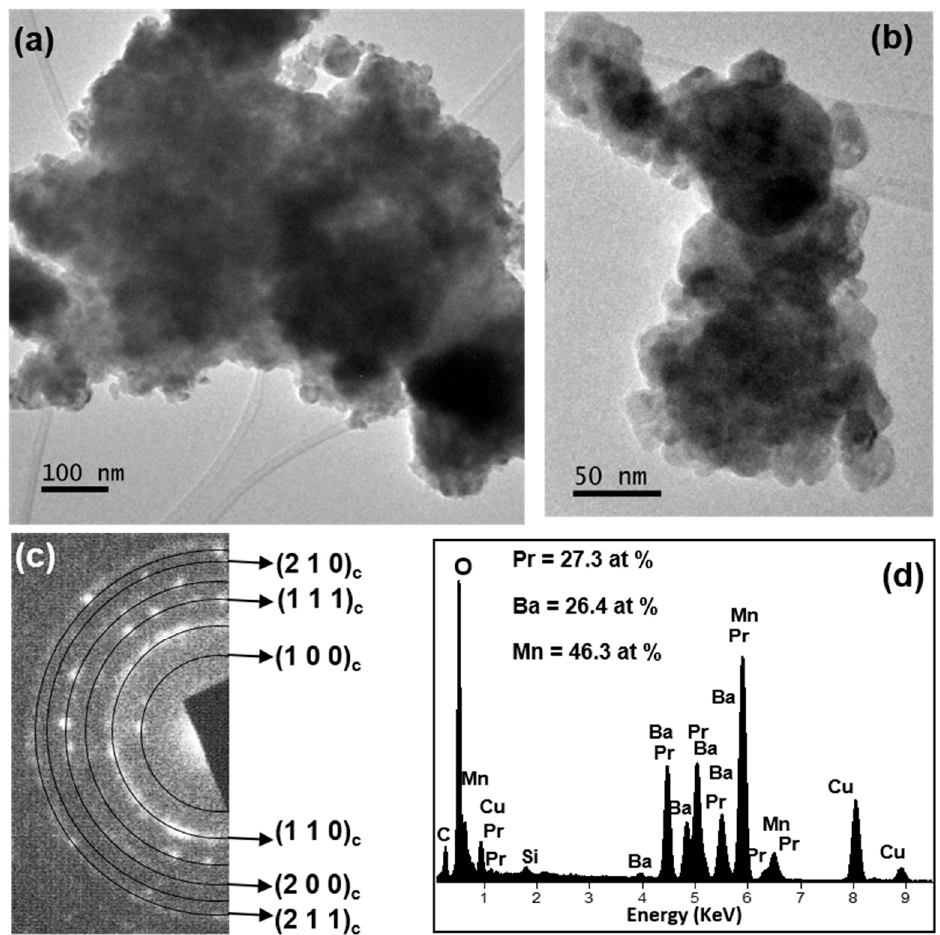
Figure 7. Microcharacterization of PBMO-m sample: ( a , b ) TEM images at different magnifications; ( c ) the corresponding selected area electron diffraction (SAED) pattern-rings and ( d ) summary results of the EDX measurements.